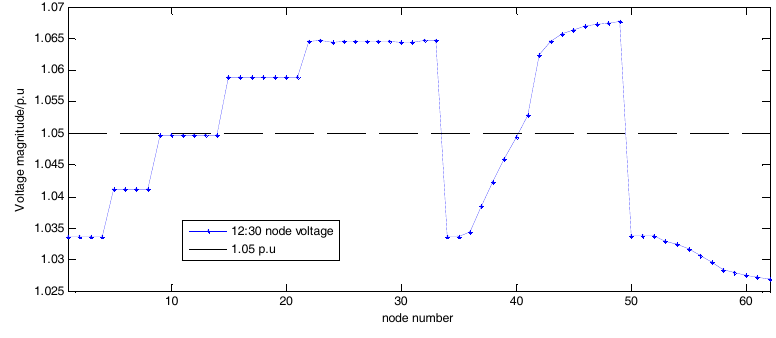
Figure 13. Node voltage at 12:30.